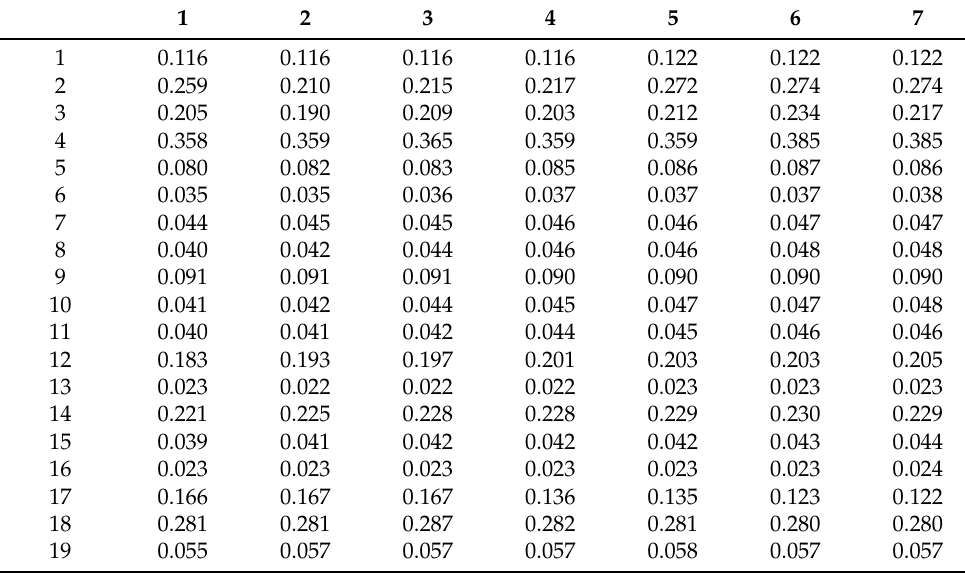
Table A3. Short-term prediction error (RMSE) of the trivial mean model—application to 19 tanks, 7-day prediction horizon.